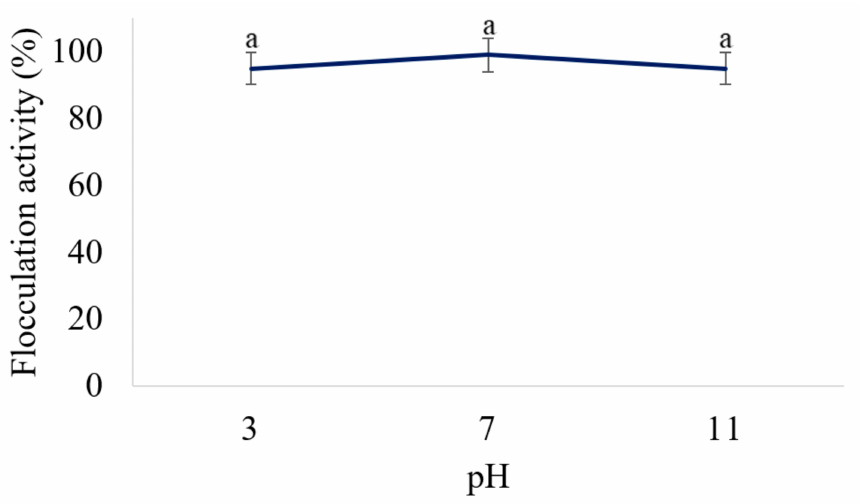
Figure 6. Effect of nanoparticle pH on flocculation activity. Letter (a) denotes statistical significance at p <